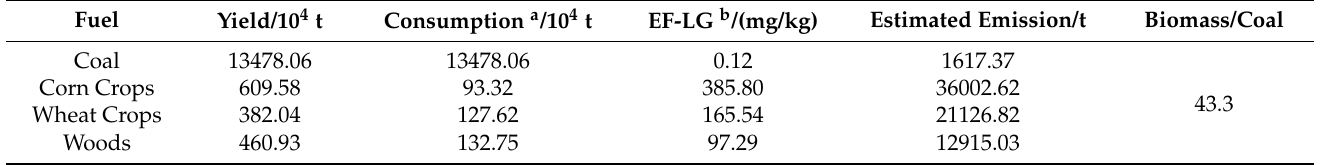
Table 6. Estimated LG emissions of biomass and coal in Shaanxi Province in 2019. Fuel Yield/10 4